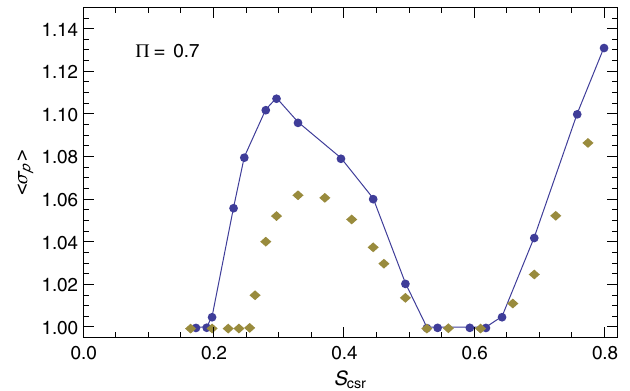
FIG. 5. For shielded CSR with (cid:1) ¼ 0 : 7 , the value of (cid:6) averaged over 400 synchrotron periods, h (cid:6) VFP simulations. The case of nominal damping (cid:5) ¼ 1 : 25 (cid:4) 10 (cid:1) 3 is given by blue circles (connected by straight lines), the case of (cid:5) ¼ 2 : 5 (cid:4) 10 (cid:1) 3 by olive